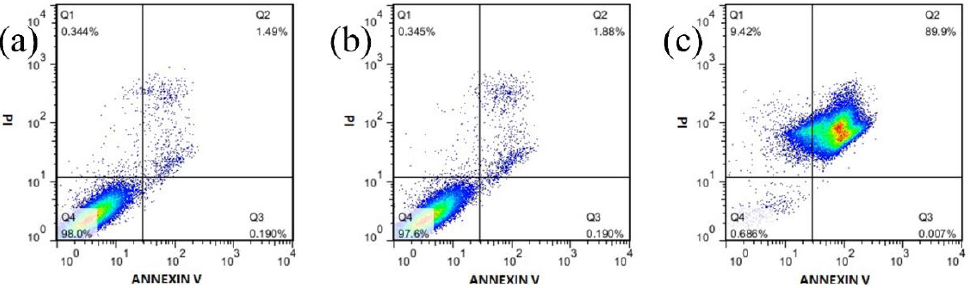
Figure 6. Flow cytometry experiments of HeLa cells when incubated with ( a ) Pure autoclave water as control, ( b ) MIL-100(Al) gels, and ( c ) DOX-loaded MOGs, respectively.